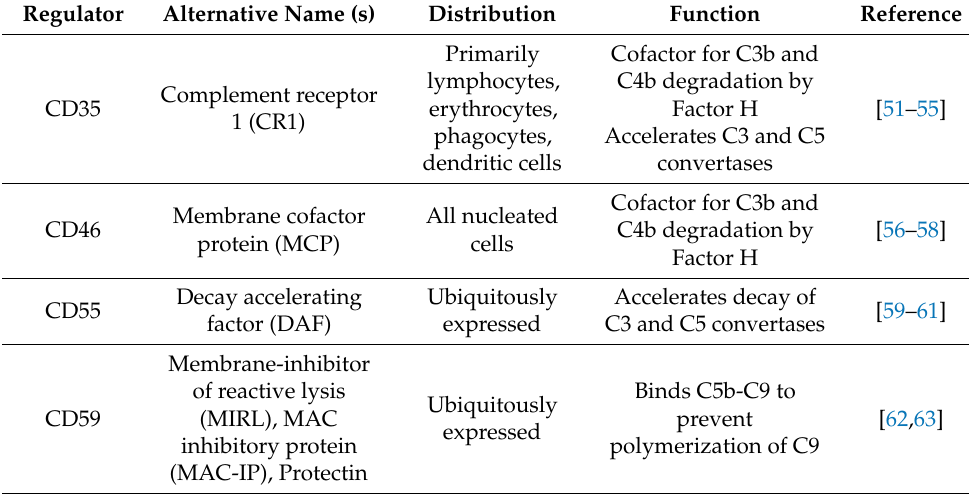
Table 1. Membrane-bound complement regulatory